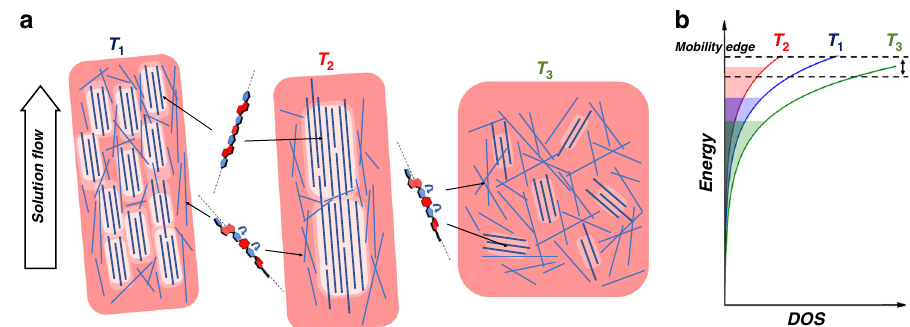
Fig. 10 Structure-transport property relationship. a Proposed sketch for the changes in the functional morphology, i.e. the morphology of the molecules involved in charge transport, of PThDPPThF4 fi lms upon annealing at T 1 , T 2 , and T 3 ; thicker lines represent crystalline polymer segments; brighter